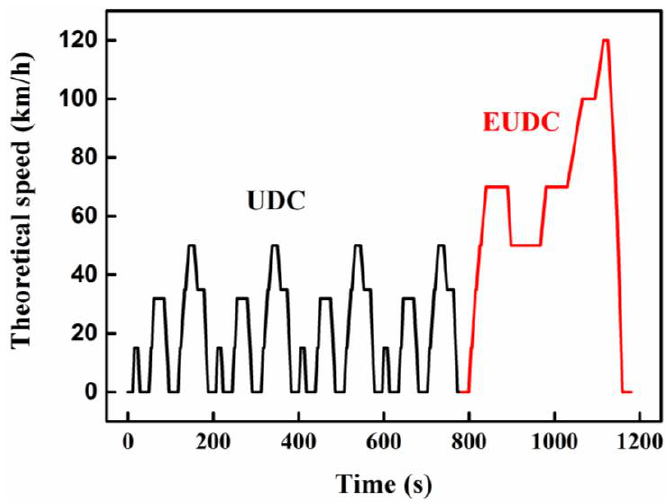
Figure 2. The theoretical speed speeds of NEDC [60].